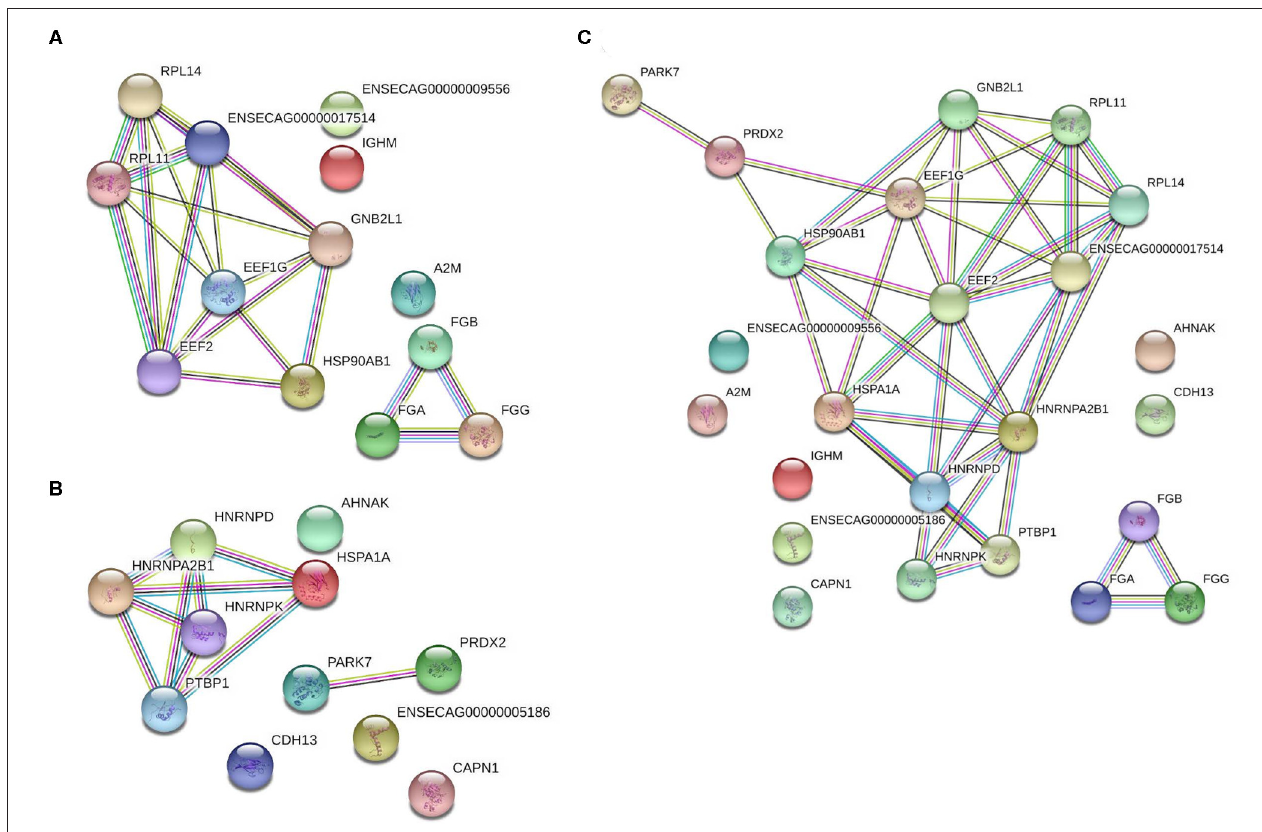
FIGURE 5 | Protein-protein interaction analysis of significantly differentially expressed proteins in the lamellar tissue of hyperinsulinemic horses as compared to controls. (A) Proteins significantly increased in hyperinsulinemic horses, (B) proteins significantly decreased in hyperinsulinemic horses, and (C) all significantly differentially expressed proteins, together. Nodes (circles) represent proteins, while edges (lines between nodes) represent protein-protein interactions. Color code for edge interactions: known interactions from: teal, curated databases; magenta, experimentally determined; predicted interactions: green, gene neighborhood; red, gene fusions; blue, gene co-occurrence; other: yellow, textmining; black, co-expression; purple, protein homology. For protein identification lists, reference accession numbers of Tables 2 , 3